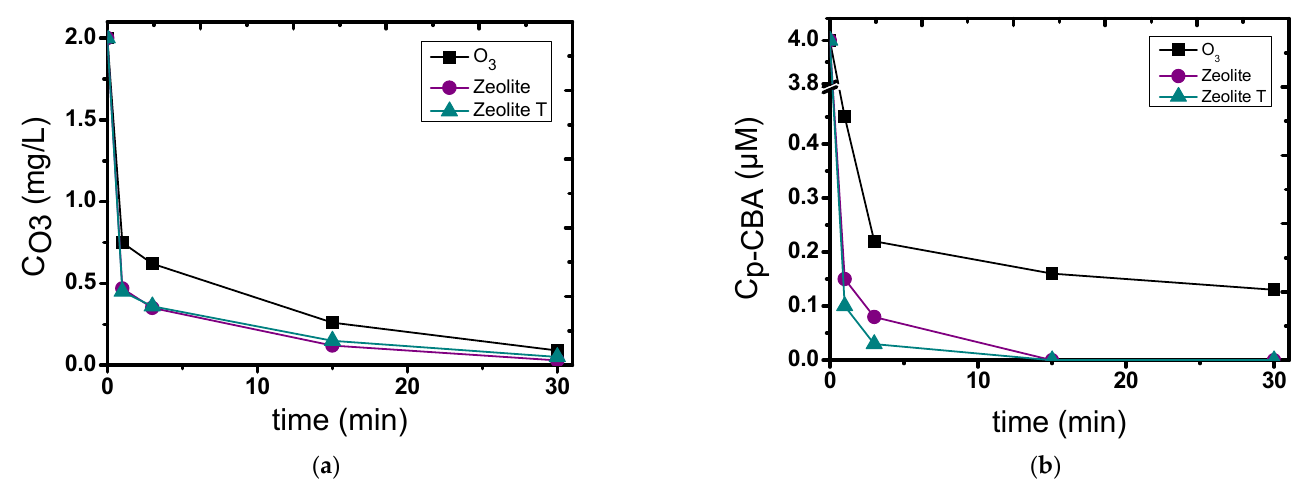
Figure 1. Comparison of single ozonation and of catalytic ozonation using zeolite or zeolite-T as potential catalysts: ( a ) ozone decomposition; ( b ) p -CBA degradation. Experimental conditions: C p-CBA 4 µ M, C O3 2 mg/L, C zeol. 0.5 g/L, pH 7, temperature 23 ± 2 ◦ C.